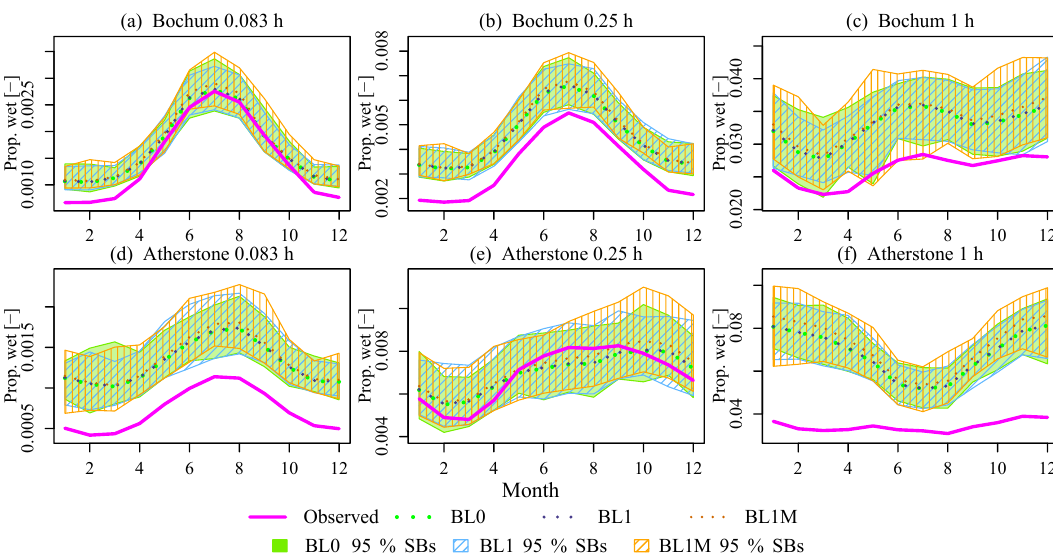
Figure 9. Seasonal variation in the proportion of wet periods for selected censors, observed vs. estimated.